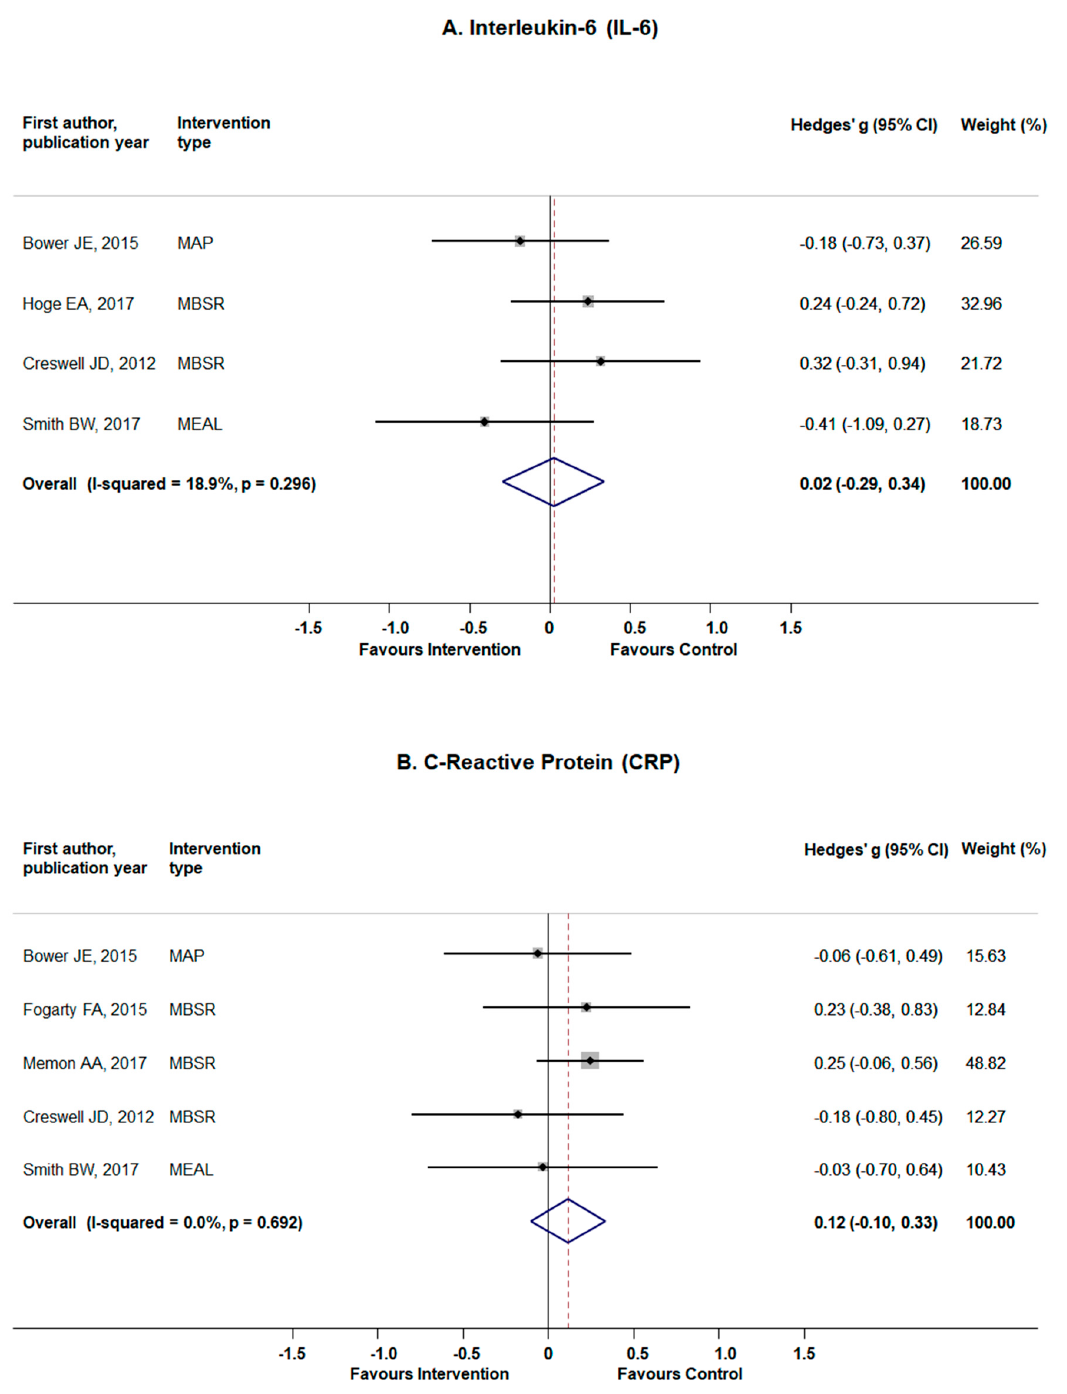
Figure 3. The effects of standardized mindfulness-based interventions on the interleukine-6 (IL-6) (panel A ) and acute phase reactant protein C-reactive protein (CRP) (panel B ). Squares indicate standardized difference in means (Hedges’ g) and lines represent 95% confidence intervals (CI); the size of the box represents the weight of each study.